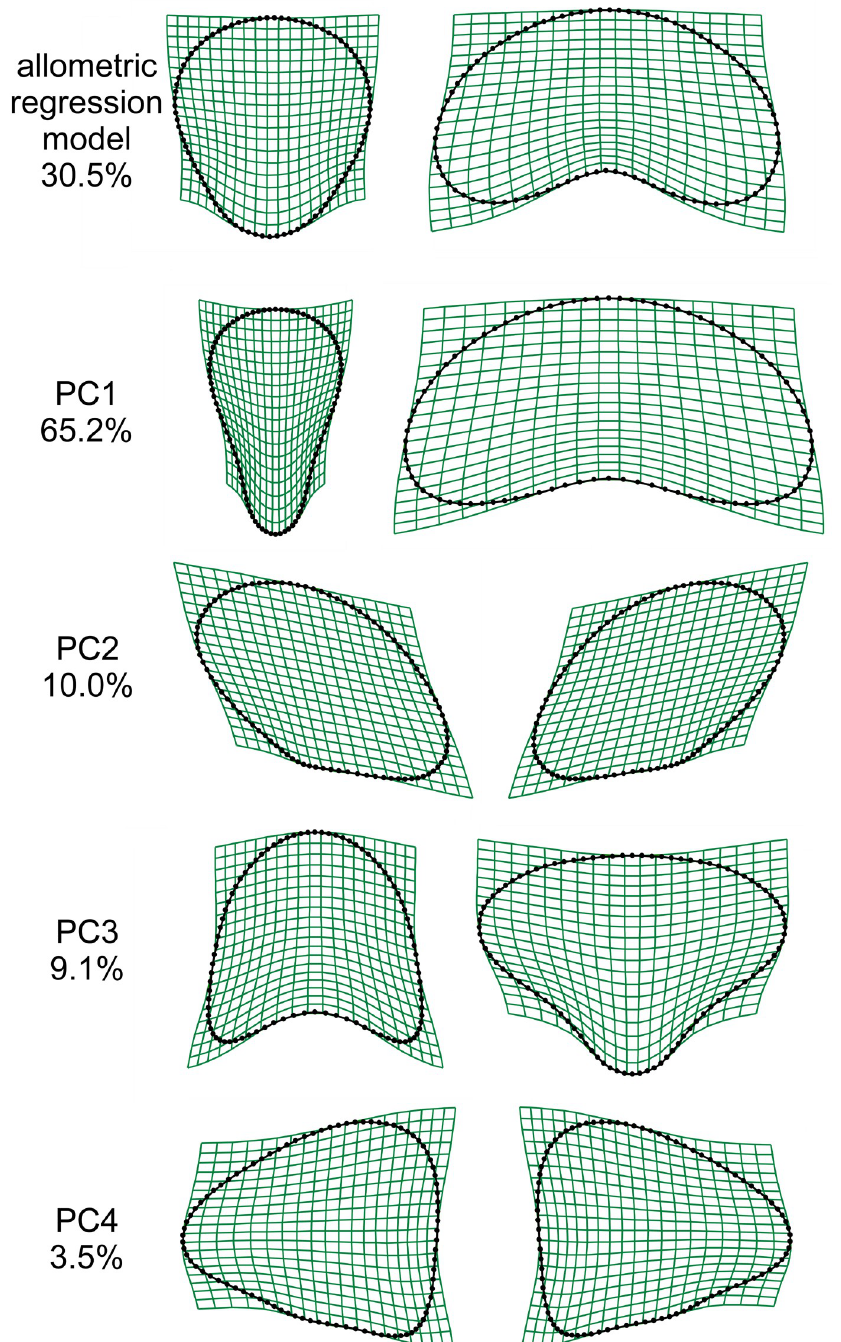
Fig 3. Thin-plate splines illustrating the multivariate allometric regression model and principal component analysis. Analyses were based on generalized Procrustes analysis including the sliding of semilandmarks using minimum bending energy criterion. Thin-plate splines depict the deformation from the consensus configuration to marginal positions on individual axes.